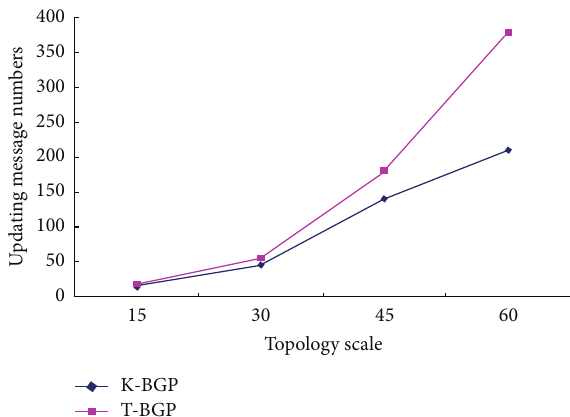
Figure 7: Comparison of numbers of updating message based on difference topology